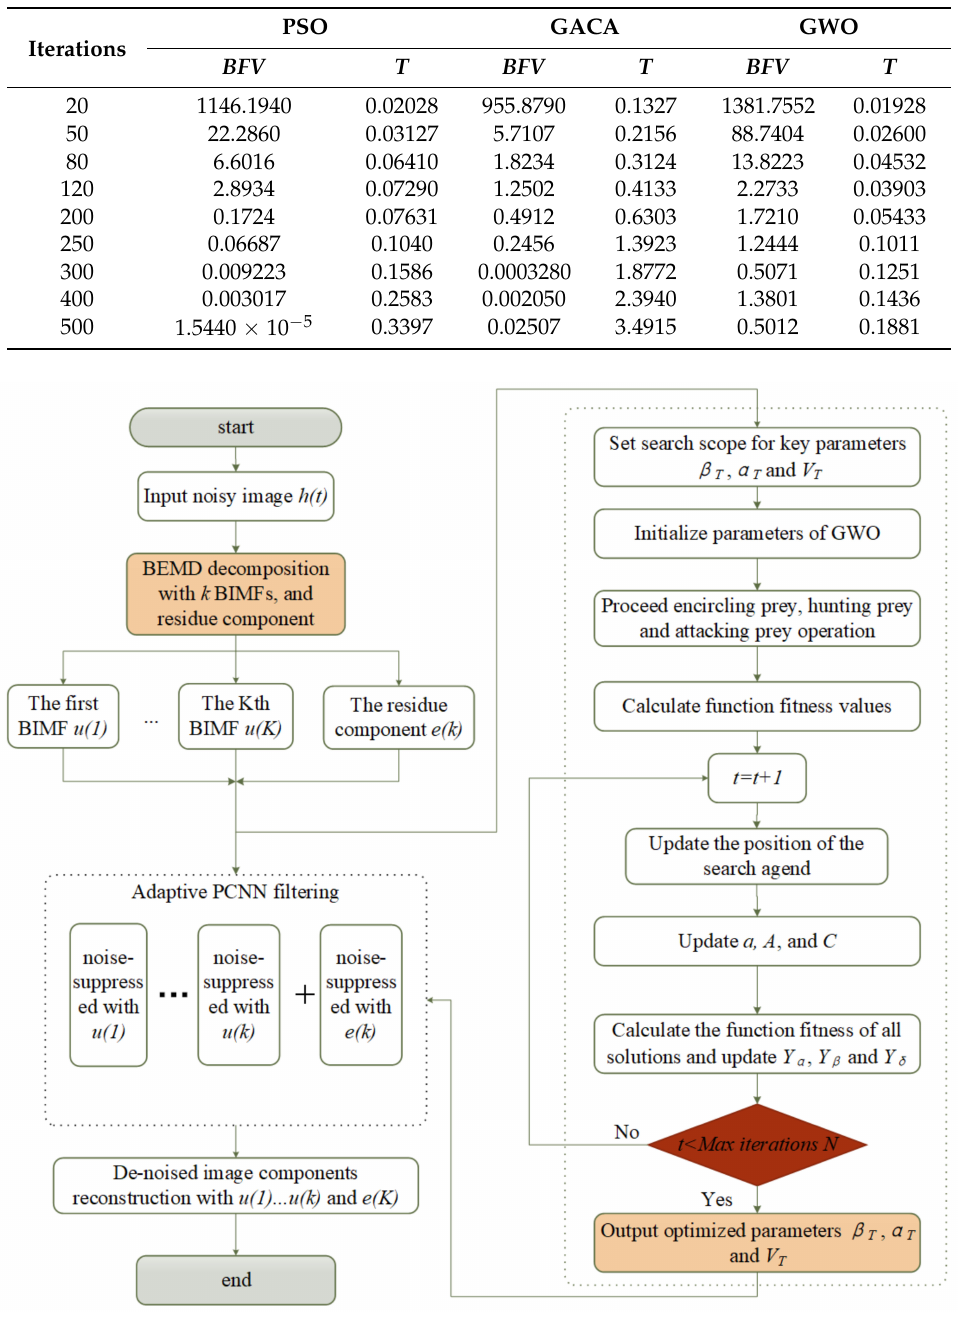
Figure 3. The flowchart of the proposed noise suppression